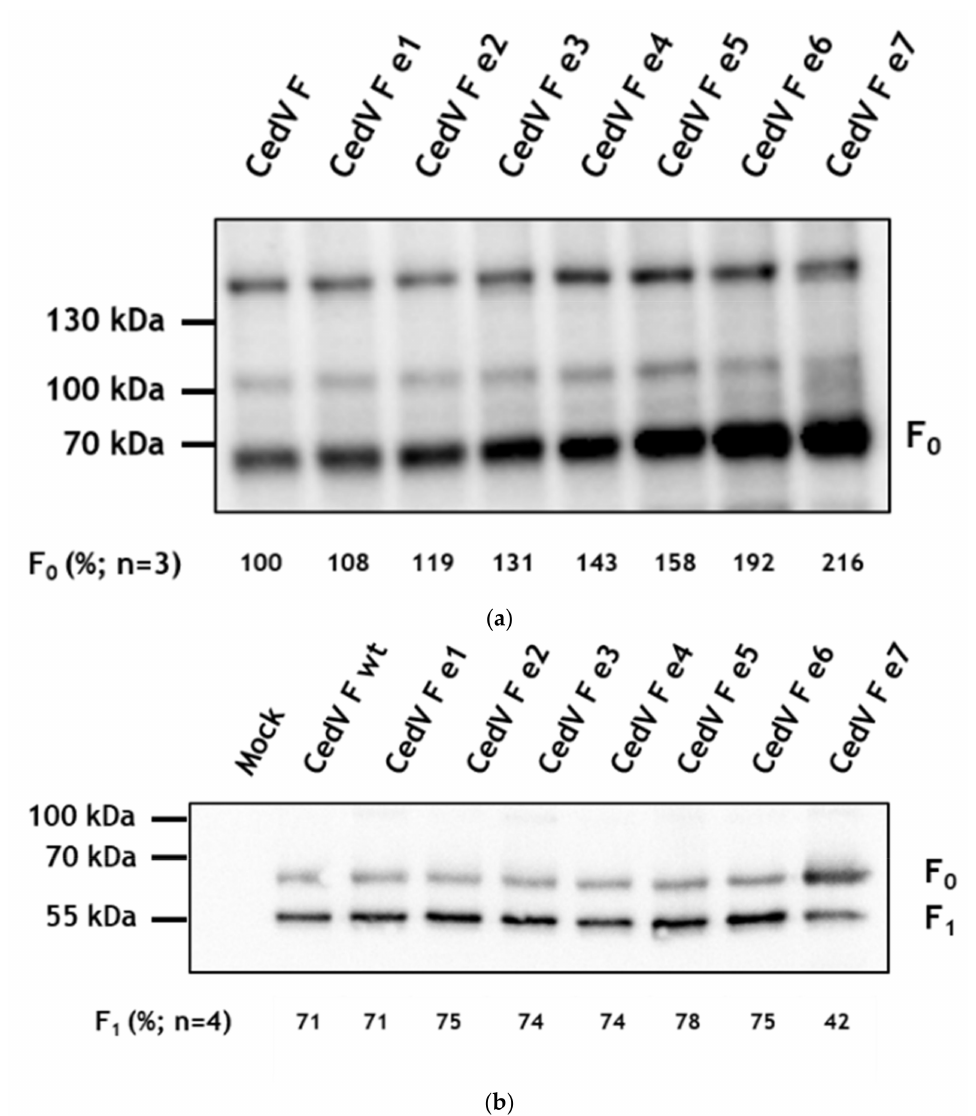
Figure 5. Cell surface expression of CedV F proteins. At 24 h p.t., MDCK-2 cells expressing F proteins were surface-labeled with biotin on ice. After cell lysis, biotinylated proteins were immunoprecipitated using NeutrAvidin beads and subjected to SDS-PAGE under non-reducing ( a ) and reducing ( b ) conditions. Precipitated F proteins were visualized using an antibody against the HA-tag (H6908), HRP-labeled secondary antibodies, and chemiluminescence. In ( a ), ConA staining is used as a loading control. Representative blots are shown from ( a ) three or ( b ) four independent experiments. The amount of F 0 and F 1 protein (in ( a ) % of CedV F 0 protein with the parental F protein set to 100% or ( b ) % of F 1 protein) is calculated as the mean of three or four independent experiments, respectively. wt: